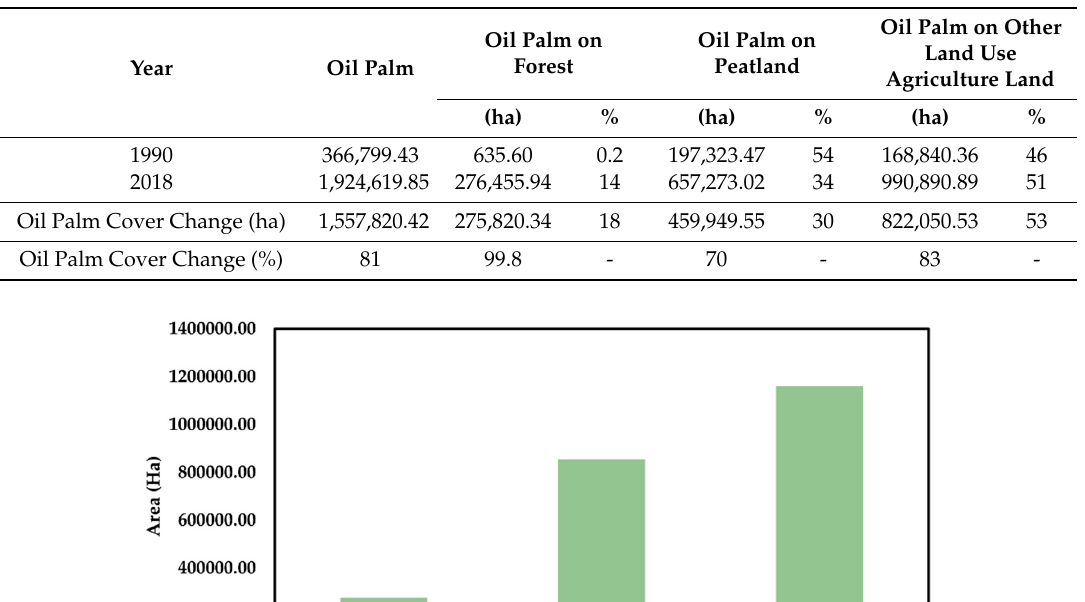
Figure 6. Sarawak oil palm development: ( a ) 1990 as the initial stat, ( b ) 2018, and ( c ) changes in oil palm development. Sabah oil palm plantation area in 1990 was more than its neighboring state, Sarawak, with a total area of 695,523 ha. Expansion of oil palm plantations occurred rapidly through 2018, with oil palm plantation area now exceeding 2 million ha, with the decadal growth in 28 years approaching 65% (1.32 million ha) (Table 8). The total area of oil palm plantations expansion in forest areas in 1990 was 172,956 ha. Expansion of oil palm plantation area since 1990 has occurred at the highest rate on other land used (agriculture land) with 74% (517,246 ha) coverage compared to the oil palm expansion on forest area and peatland area with 25% (172,956 ha) and 1% (5321 ha), respectively. Meanwhile, in 2018, there were 2 million ha of oil palm planted in Sabah, with 14% planted in forest (276,431 ha). The other 2% and 84% of the total oil palm plantation were planted on peatland and other land use